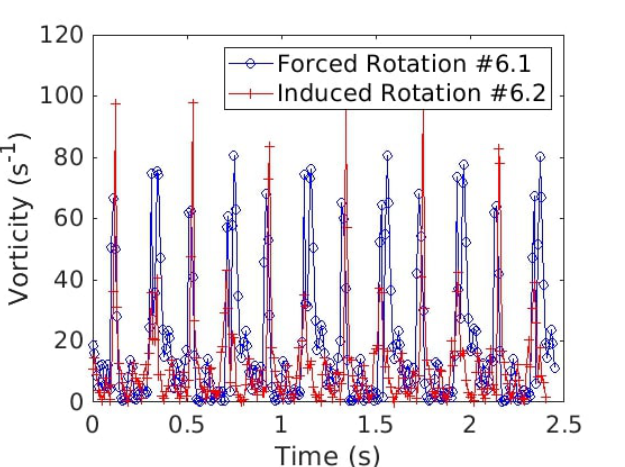
Figure 34. Time evolution of the fluid vorticity at the probe location for forced (blue line, #6.1) and induced (red line, #6.2)